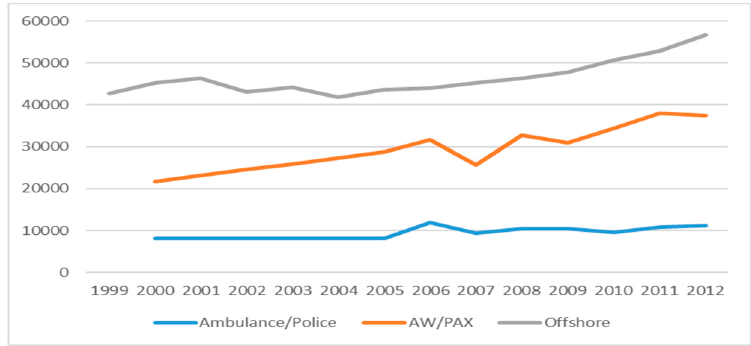
Figure 2. Yearly flight hours—offshore and onshore.